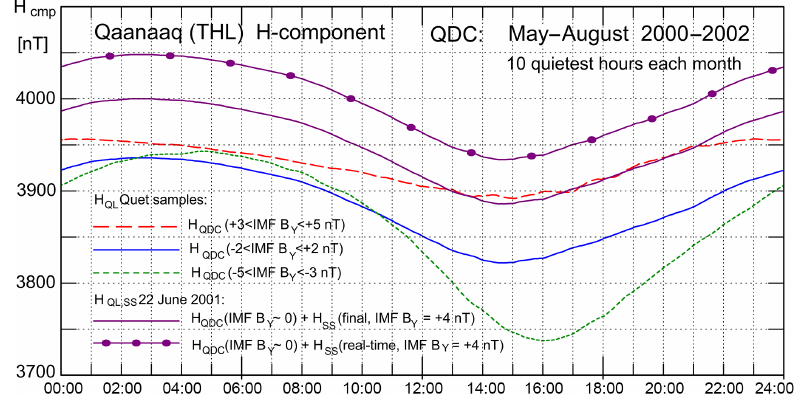
Figure 2. Qaanaaq (Thule) H -component data averaged through the 10 quietest hours of the summer months in 2000–2002 for groups of data with − 5 < IMF B Y < − 3nT (green dotted line), − 2 < IMF B Y < + 2nT (solid blue line), and + 3 < IMF B Y < + 5nT (red dashed line), respectively. H QL , SS for 22 June 2001 in “final” (solid magenta line) and “real-time” (magenta line with dots) versions (see text). Local solar and magnetic noon are at around